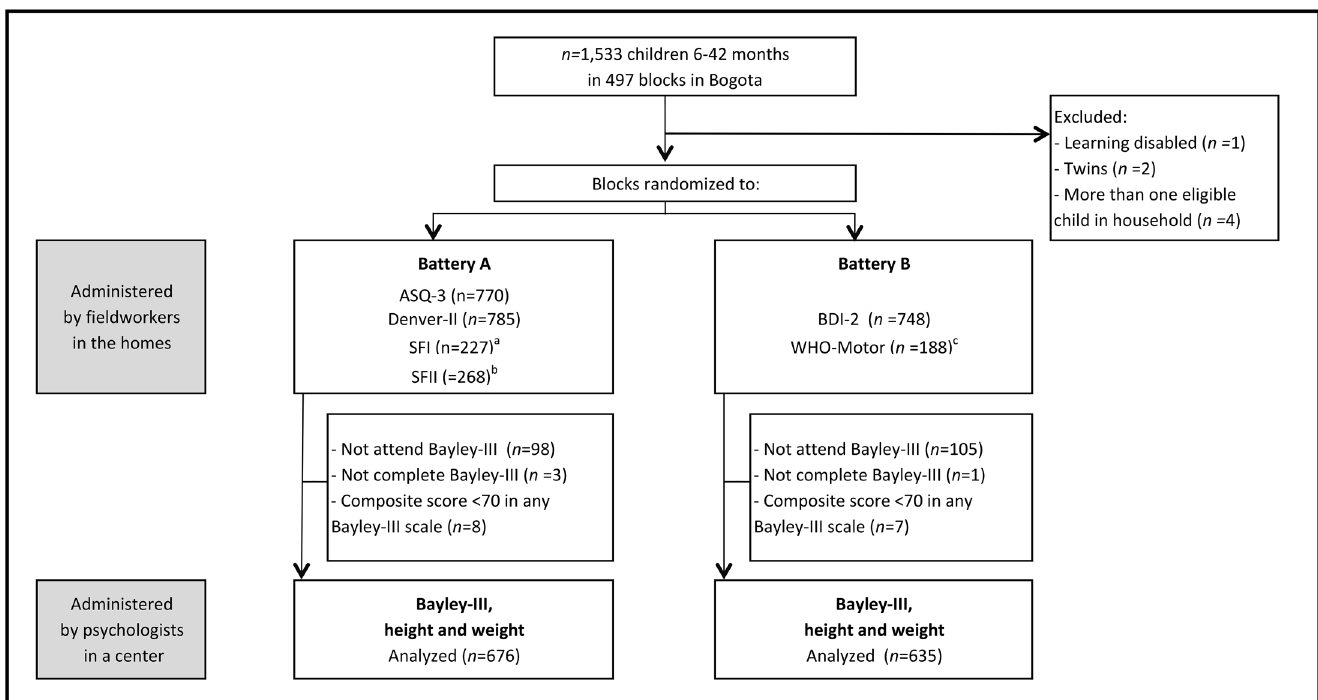
Fig 1. Flow Diagram of Study Participants and Study Design. a Children 8 – 18 months. b Children 19 – 30 months. c Children 6 – 15